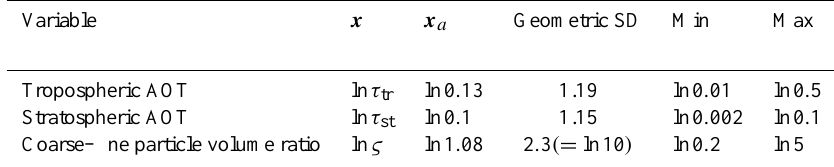
Table 4. Prior information and its error range for the state vector elements. Variable